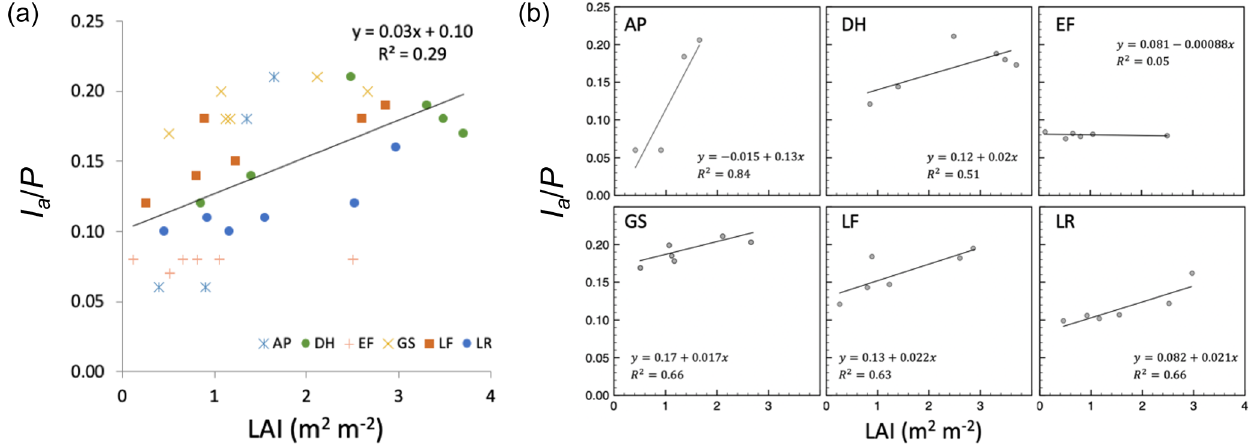
Figure 5. (a) Annual proportion of rainfall that is intercepted ( I a /P ) versus LAI for all sites and plots. (b) Site-specific I a /P versus LAI relationships. The relationship is generally strong except for the EF site, where the overall storage capacity is small across all values of LAI.